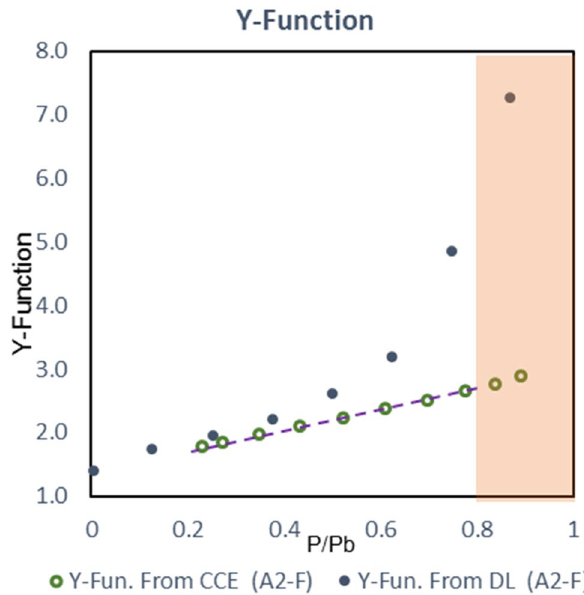
Fig. 25 Invalid trend of Y-function of DL test—(A2-F)